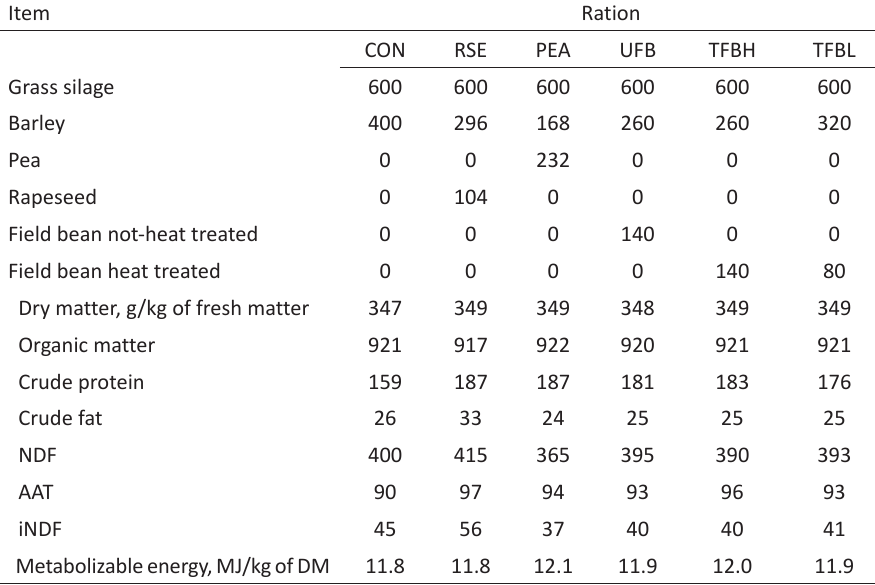
Table 1. Ration ingredients and chemical composition (g kg -1 DM unless otherwise